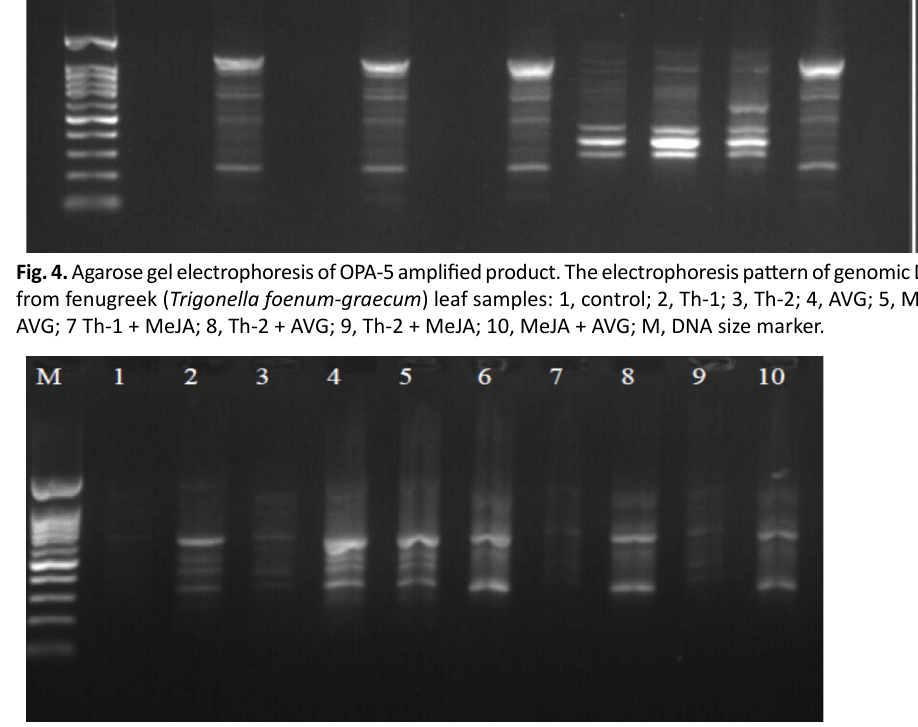
Fig. 5. Agarose gel electrophoresis of OPF-5 amplified product. The electrophoresis pattern of genomic DNA extracted from fenugreek ( Trigonella foenum-graecum ) leaf samples: 1, control; 2, Th-1; 3, Th-2; 4, AVG; 5, MeJA; 6, Th-1 + AVG; 7 Th-1 + MeJA; 8, Th-2 + AVG; 9, Th-2 + MeJA; 10, MeJA + AVG; M, DNA size marker. Electrophoresis conditions: 1% agarose concentration, 75 V, 20 mA for 120 min, stained with ethidium